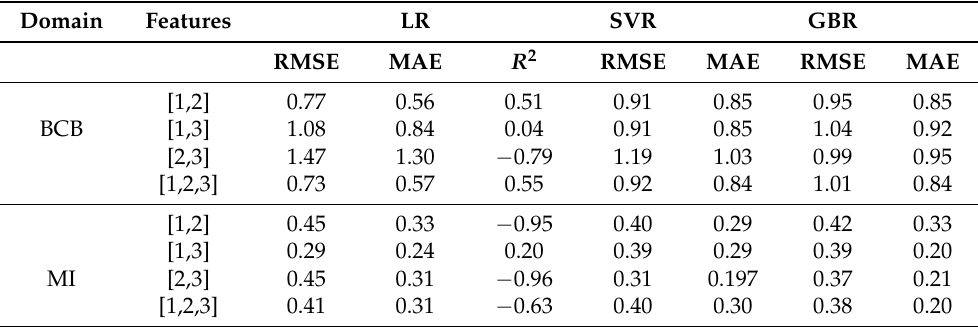
Table 5. The performances of regression models for predicting SJR utilizing various input features ([1] = citation, [2] = h-index, [3] =